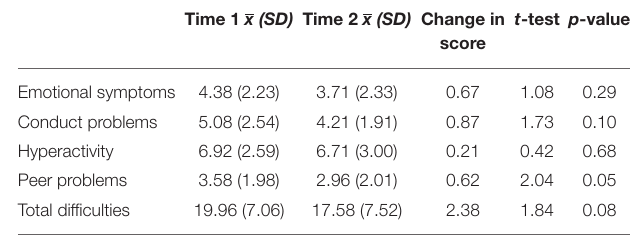
TABLE 5 | Change over time SDQ completed by matched pairs different respondents ( n = 42).